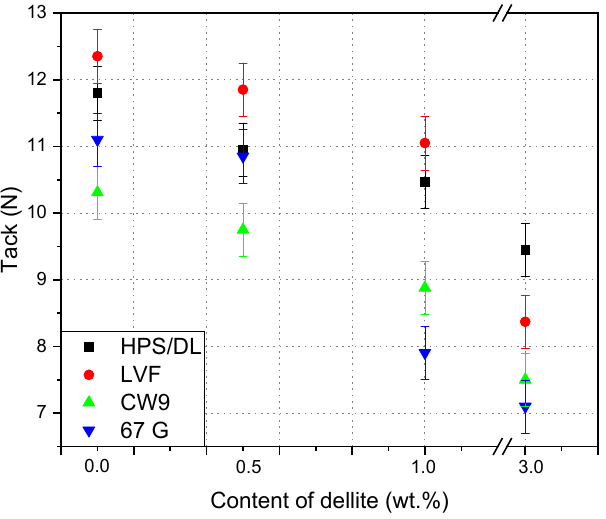
Figure 4. Effect of contents of dellite addition on the tack of silicone pressure-sensitive adhesives.